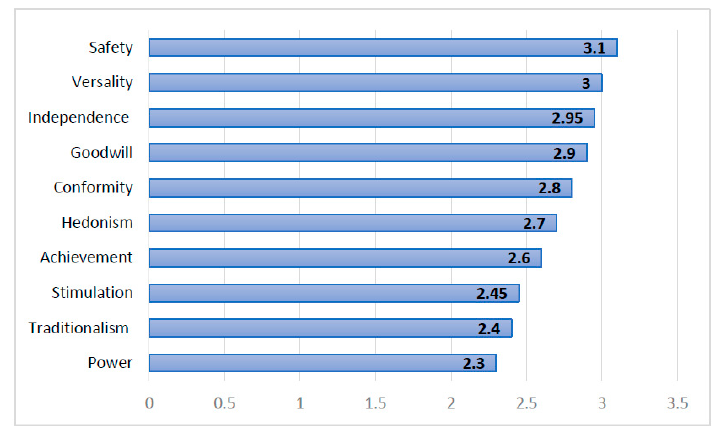
Figure 7. Average estimates of the significance of universal values for car owners.